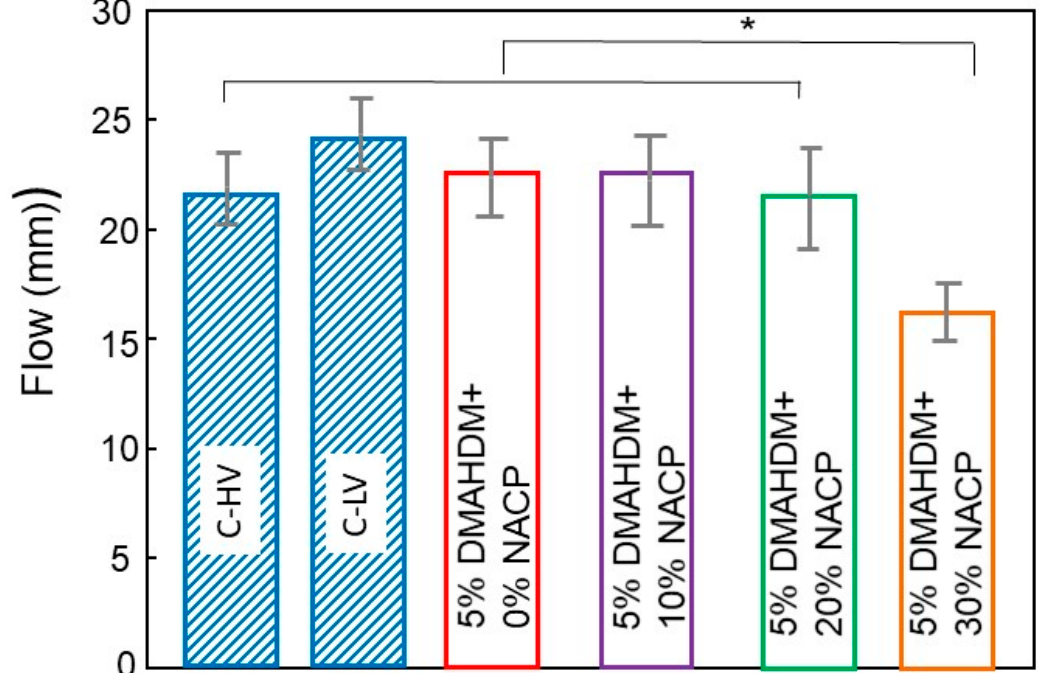
Figure 3. Means ± SD of flow analysis of the resin-based sealant formulations ( n = 6). The asterisk means that there was a statistically significant difference between the groups.